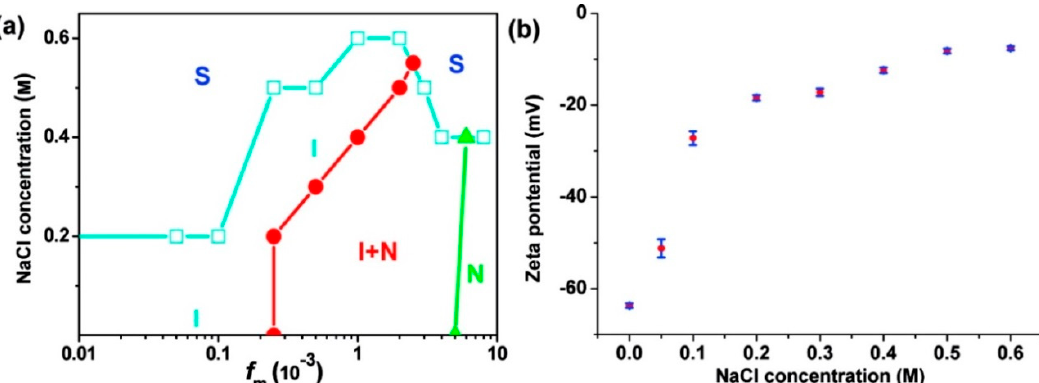
Figure 10. The dependence of ( a ) the phase diagram of a GO-LC (where f m is the mass fraction of GO) and ( b ) the zeta potential of the GO dispersion on the concentration of NaCl salt in the solution. Reprinted with permission from Xu and Gao. [12] Copyright (2011) American Chemical Society.